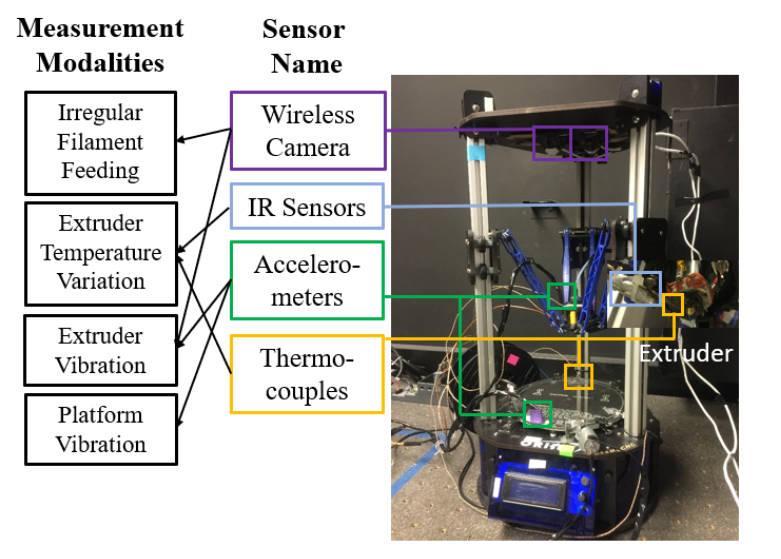
Figure 1. A Delta fused deposition modeling (FDM) Printer with a Multi-Modal Sensing System (Redrawn from [18] with author’s